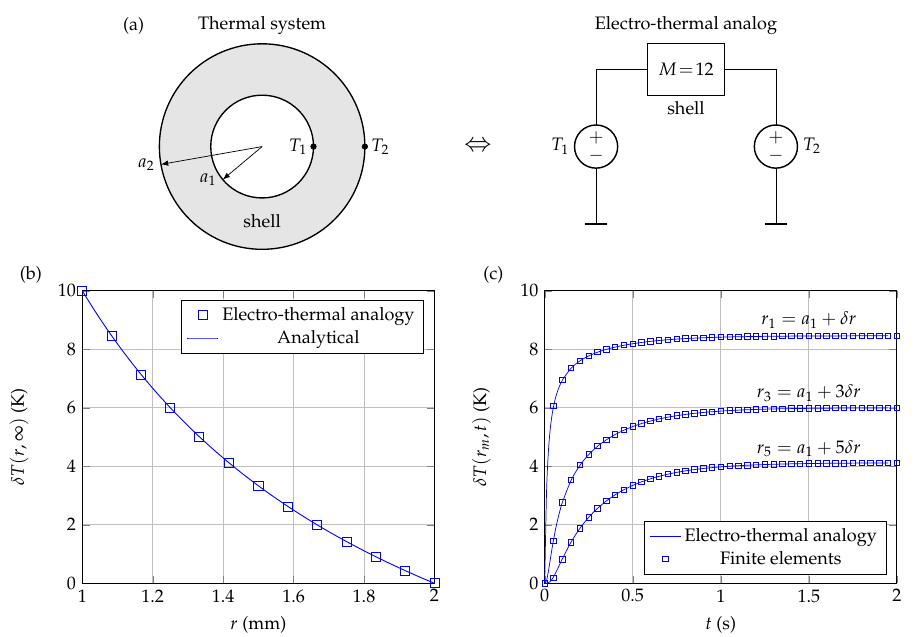
Figure 7. ( a ) Electro-thermal modeling of a shell subjected to Dirichlet’s boundary conditions, without heat volumetric source. ( b ) Stationary temperature profile through the shell. ( c ) Temperature variations as a function of time at different points throughout the shell.